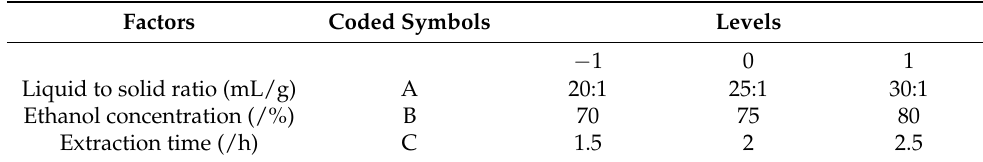
Table 4. Independent variables and their levels used for BBD.